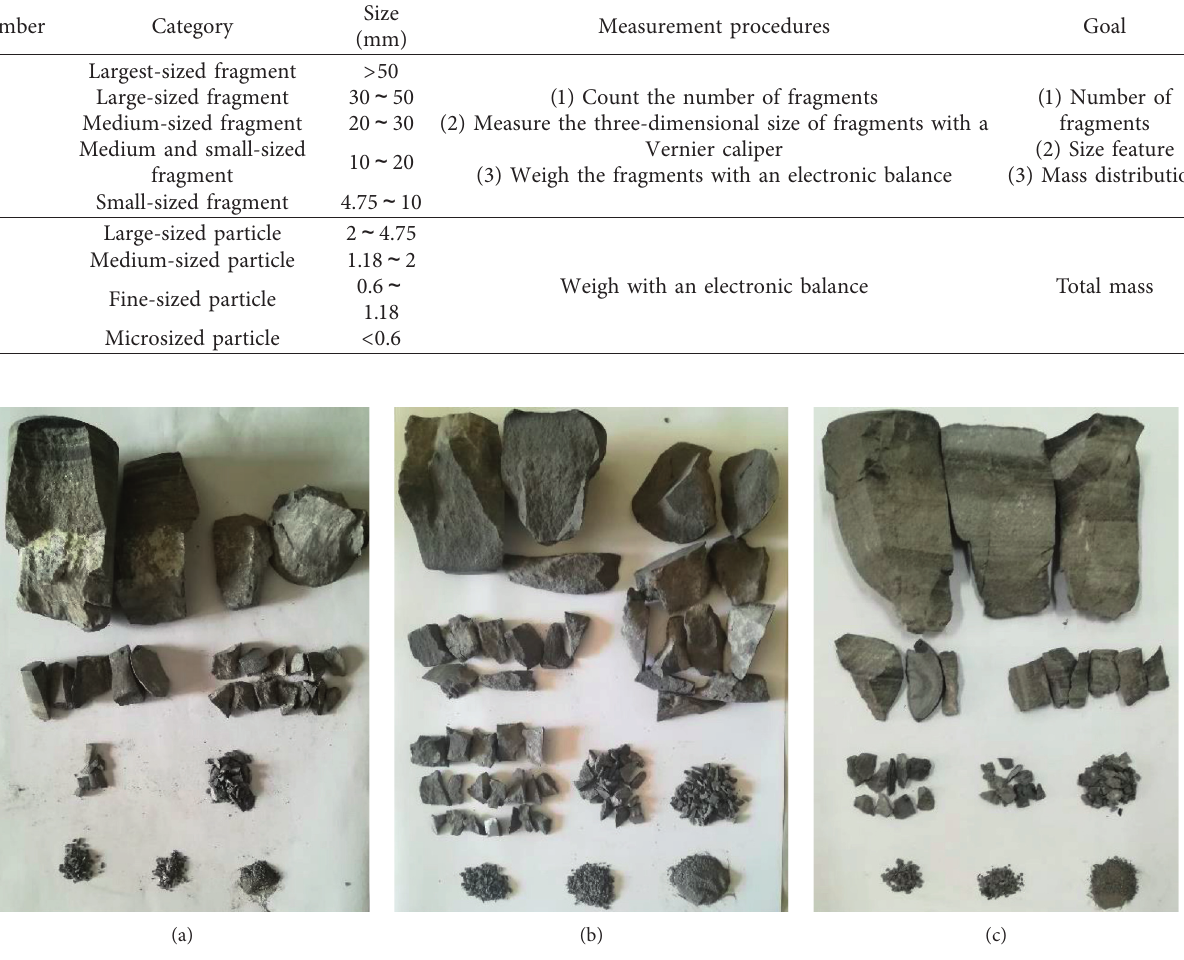
Figure 7: Sieving results of limestone fragments obtained under the uniaxial stress state. (a) Conventional compression test. (b) Cyclic loading test with a frequency of 0.25Hz. (c) Cyclic loading test with a frequency of